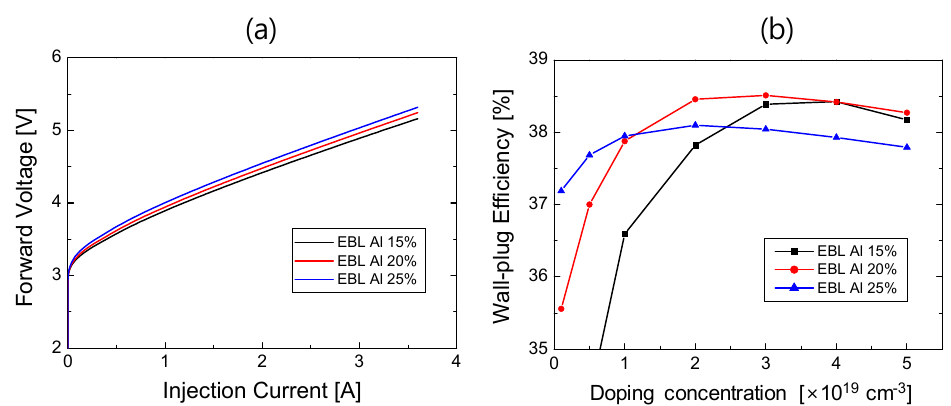
Figure 7. ( a ) V–I curves for the EBL Al compositions of 15%, 20%, and 25%. ( b ) WPE as a function of the Mg doping concentration for the Al compositions of 15%, 20%, and 25%.